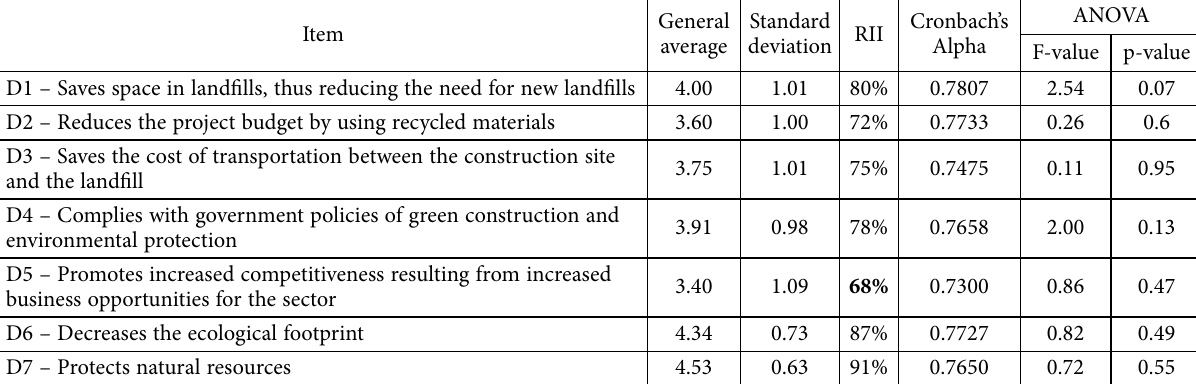
Table 8. Analysis of the general survey sample data regarding the benefits of CDW reuse and recycling (Cronbach’s alpha = 0.7898)